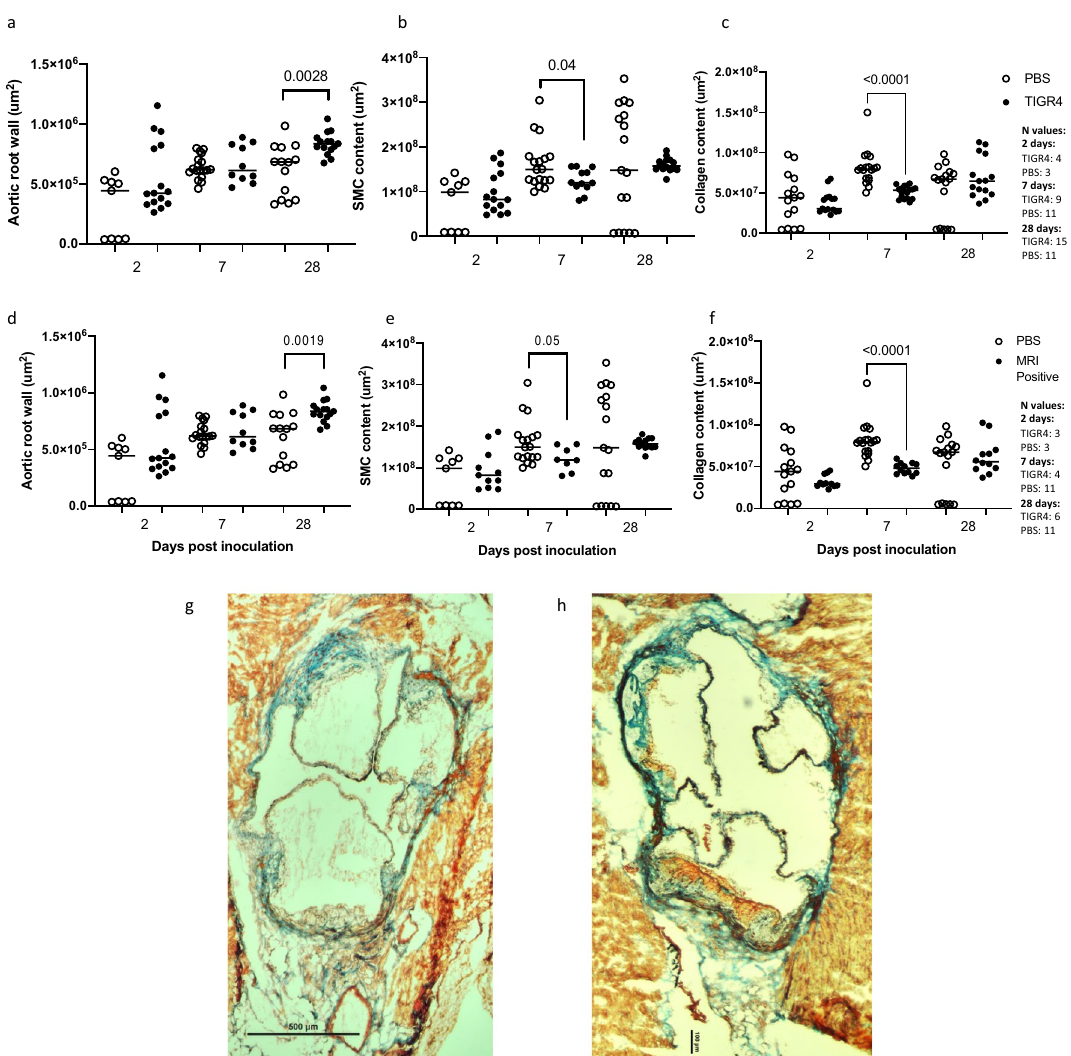
Figure 2. Assessment of aortic root remodelling and plaque structure using trichrome staining. ( a ) Total area of aortic wall was quantified to assess inward and outward remodeling as a result of atherosclerosis. 28 days post-inoculation (PI), TIGR4 inoculated mice present with significantly more aortic wall remodelling. 8 μm tissue sections were stained with modified trichrome stain to identify collagen and smooth muscle cells (SMC). Following colour deconvolution, SMC ( b ) and collagen ( c ) intensity per area in aortic root were calculated. Significantly less SMC and collagen were present in the plaques of TIGR4 inoculated mice compared to PBS inoculated mice at 7 days PI. Moreover, aortic remodelling, plaque-SMC and -collagen content in TIGR4- inoculated mice with confirmed pulmonary abnormalities (MRI positive) were compared to PBS-inoculated mice ( d ), ( e ) and ( f ), respectively. Similar significant comparisons were observed. ( g ) and ( h ) are representative images of aortic root from TIGR4- and PBS-inoculated mice, respectively (taken at Inflammatory markers in the aortic root following TIGR4 infection. As significant differences in remodelling were observed only at 28 days PI, immunofluorescence staining was performed at this time-point to identify macrophages (Fig. 3a) and inflammasome activation (Fig. 3c). Quantitation of F4/80 and NLRP3 were expressed as staining intensity per area. Intraplaque macrophage content (Fig. 3b) and NLRP3 inflamma- some staining (Fig. 3d) were comparable in TIGR4- and PBS-inoculated mice. Furthermore, F4/80 and NLRP3 staining did not differ between TIGR4-inoculated mice with pulmonary infection and PBS-inoculated mice (Supplementary Fig. 2). FDG uptake in aortic arch. FDG uptake was assessed to determine degree of inflammation in the aor- tic arch from TIGR4-inoculated (n = 10) and PBS-inoculated (n = 9) mice. Consistent with the findings from the immunofluorescence staining, there were no significant changes in FDG standardised uptake values (SUV) across all time-points (Fig. 4a,b).